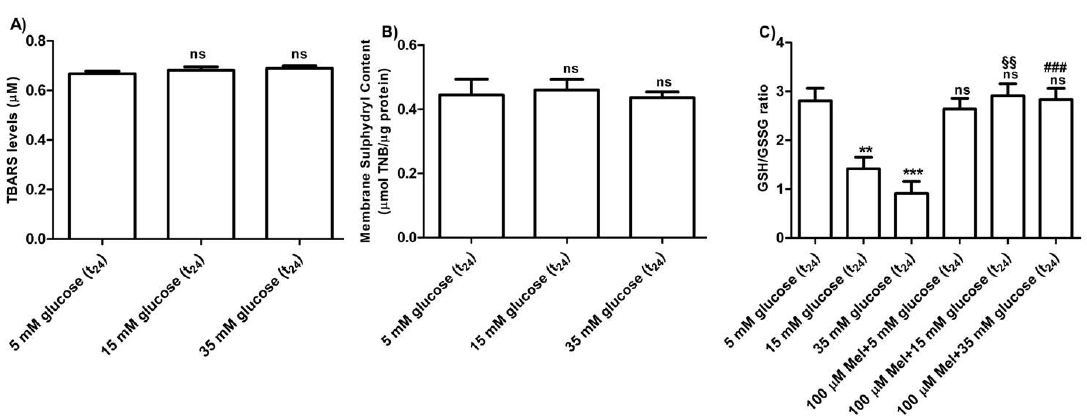
Figure 7. ( A ) TBARS levels (µM) measured in glucose-treated erythrocytes incubated for 24 h at different glucose concentrations (5-15-35 mM). ns ( not significant) versus 5 mM glucose (t 24 ) (control) as determined by Bonferroni’s post-hoc test ( n = 8). ( B ) Membrane sulfhydryl content measured as µmol TNB/µg protein in glucose-treated erythrocytes (5-15-35 mM glucose) incubated for 24 h. ns (not significant) versus control by Bonferroni’s post-hoc test (n = 8). ( C ) Estimation of the GSH/GSSG ratio measured in glucose-treated erythrocytes at different concentrations (5-15-35 mM glucose) incubated for 24 h. ns (not significant) versus control; *** p < 0.001 significant versus control; §§ p < 0.01 versus 15 mM glucose and ### p < 0.001 significant versus 35 mM glucose as determined by one-way ANOVA followed by Bonferroni’s post-hoc test ( n =